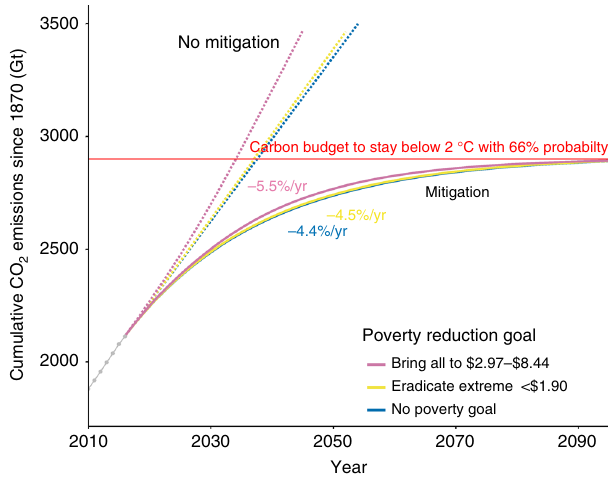
Fig. 4 Historic cumulative global CO 2 emissions from 1870 through 2015 and predicted paths. Gray dots before 2015 shows historical cumulative CO 2 emissions since 1870 in Gigatons (Gt). Solid lines after 2015 shows predicted paths for each scenario and required annual reduction in carbon intensity in percent to stay below 2 °C above pre-industrial levels with 66% chance. Dotted lines after 2015 show predicted carbon emission paths if no mitigation measures are